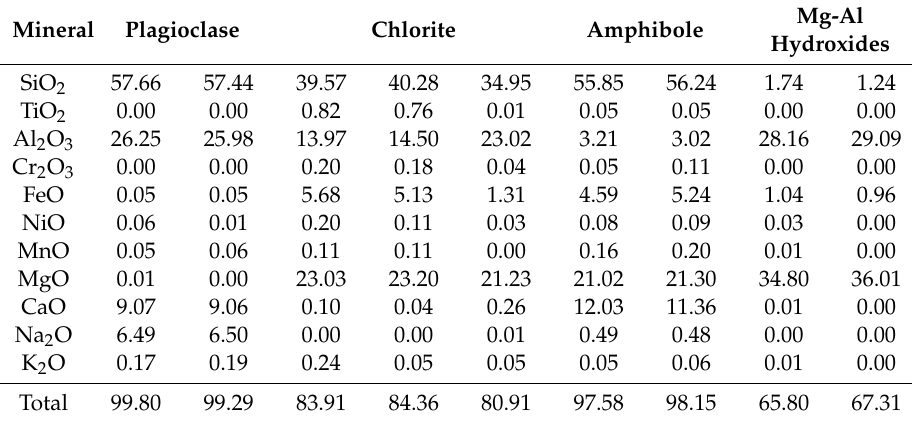
Table 6. Representative analyses (EMPA) of the sample W3